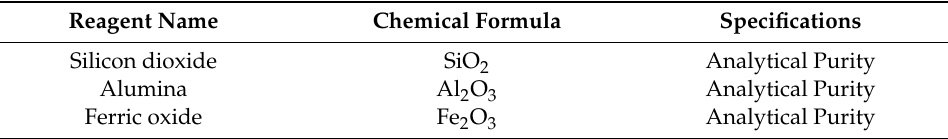
Table 2. Reagents used in experiments.